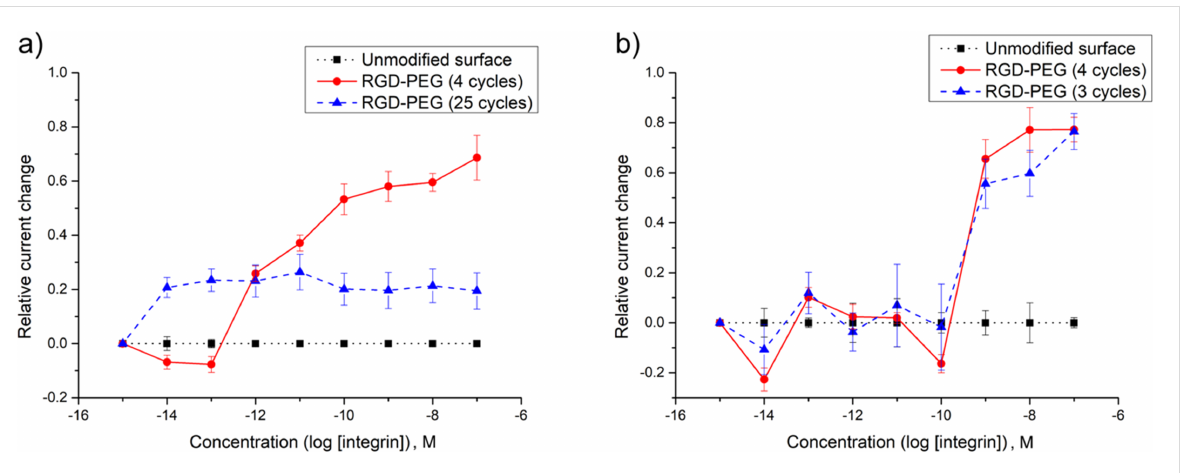
Figure 8: Repeating the experiment on different arrays. (a) A comparison between a 4-cycle placement reaction and a 25-cycle placement reaction. (b) 3 vs. 4 cycles.